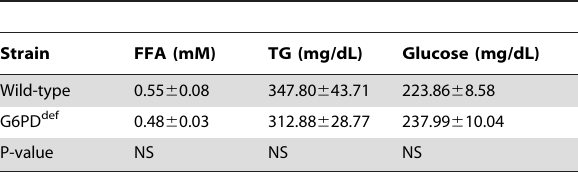
Table 3. Serum free fatty acid, triglycerides and glucose levels in G6PD deficient mice (n=5).